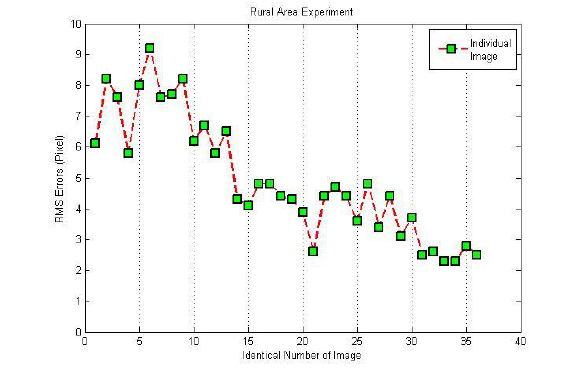
Figure 5. The plot of the RMS errors of the hills’ area test for each image